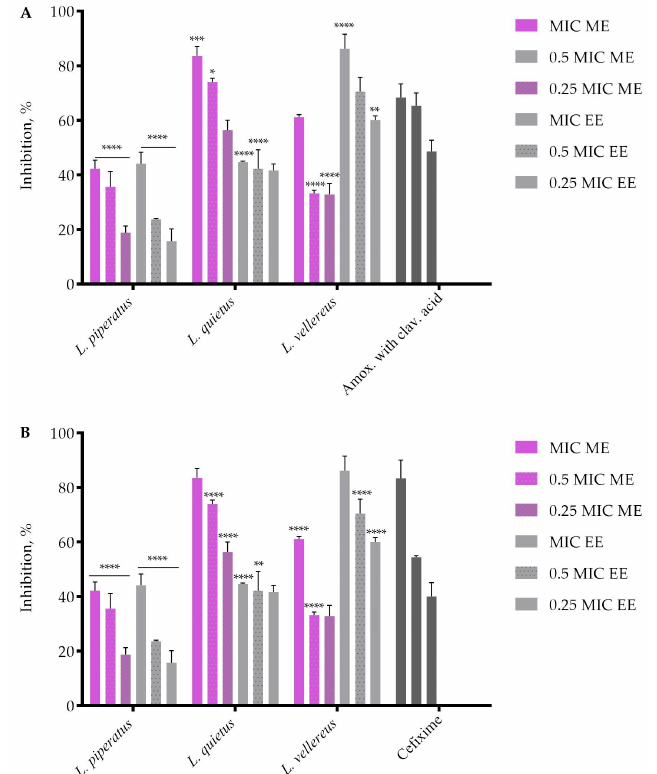
Figure 1. Formation of S. aureus biofilm after treatment with Lactarius extracts compared to commercial drugs: ( A ) amoxicillin with clavulanic acid; ( B ) cefixime. The error bars indicate standard deviations. The asterisks represent statistical significance *, p ≤ 0.05; **, p ≤ 0.01; ***, p ≤ 0.001, ****, p ≤ 0.0001, the data are presented as mean ± SD.